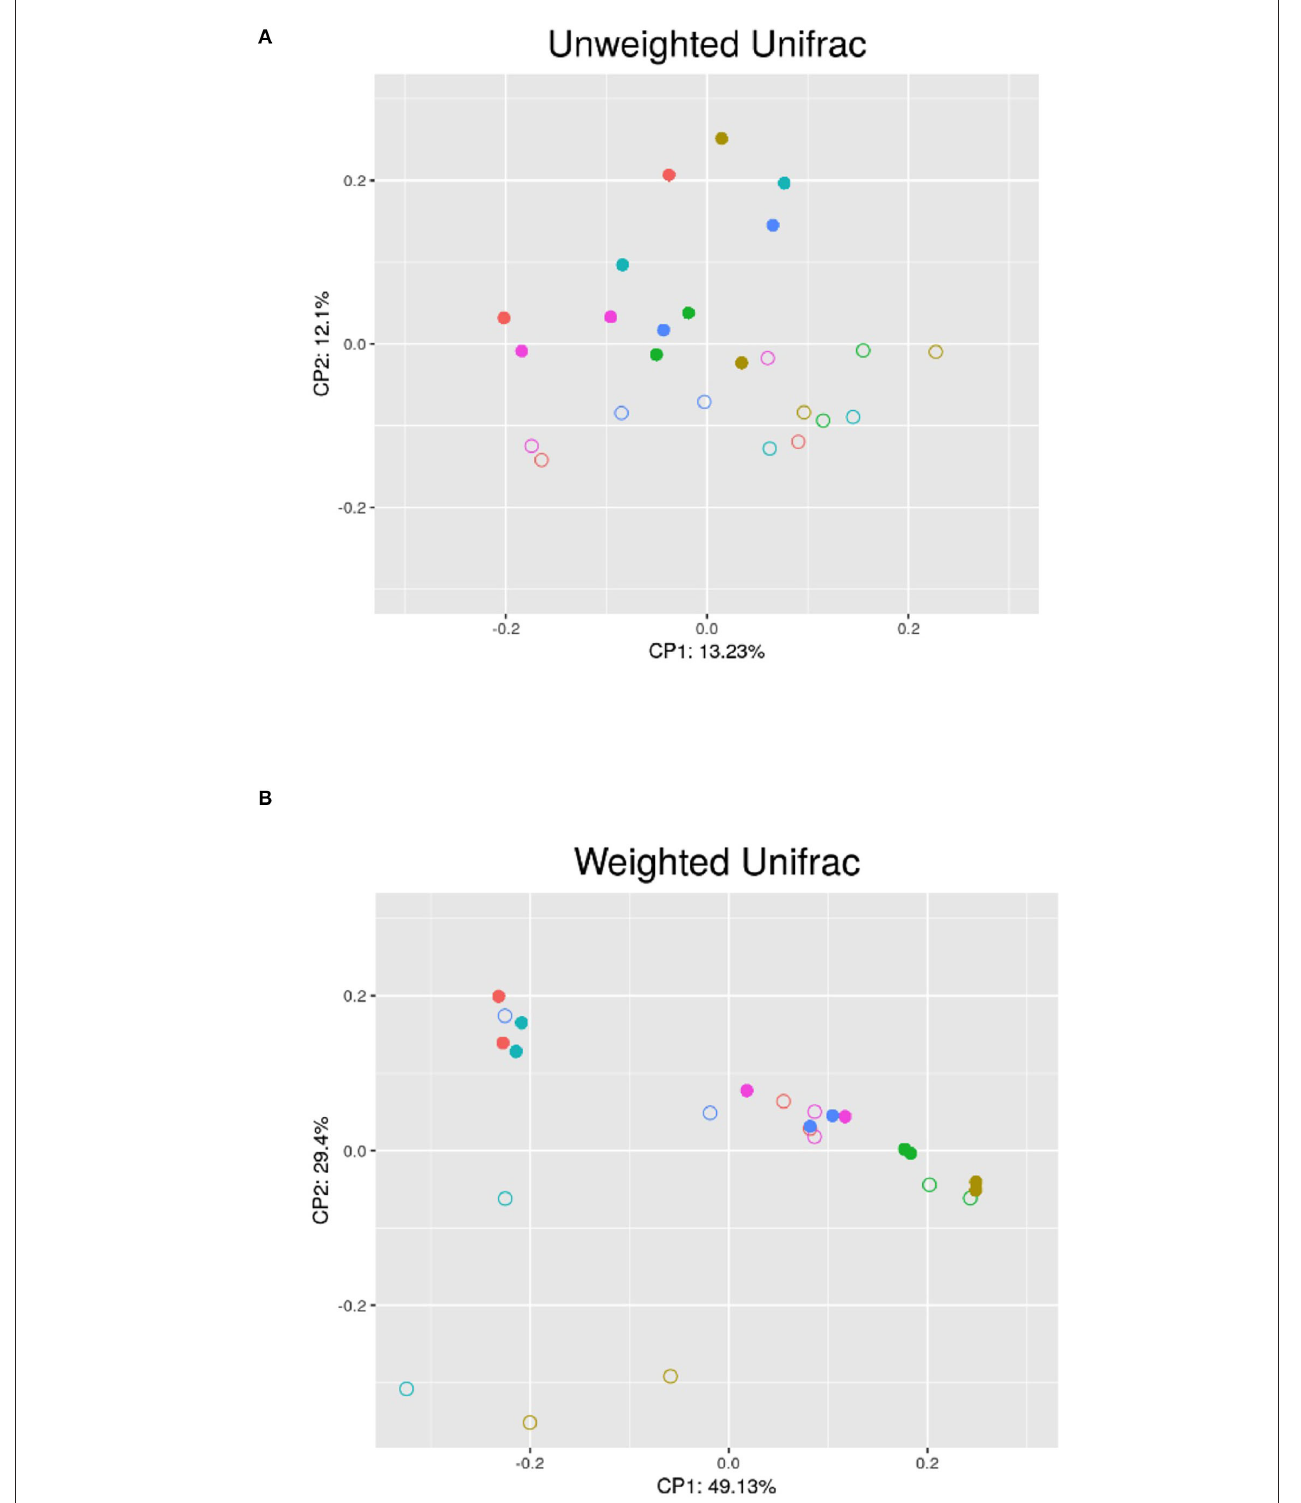
FIGURE 2 | PCoA analysis of the semen microbiota in the different bucks (each color belongs to a different buck) between the non-breeding (•) and breeding ( ◦ ) seasons; (A) Unweighted UniFrac PCoA; (B) Weighted UniFrac PCoA; CP1 and CP2: first and second principal coordinates.